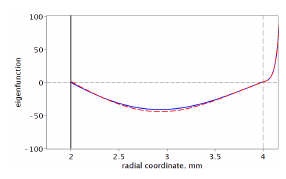
Figure 4. Nonlinearity coefficient α = 2 × 10 − 4 mm/V. Marked eigenvalues: linear eigenvalue β ≈ 5 . 0815 (blue dot); nonlinear eigenvalue β ≈ 5 . 1623 (red dot).